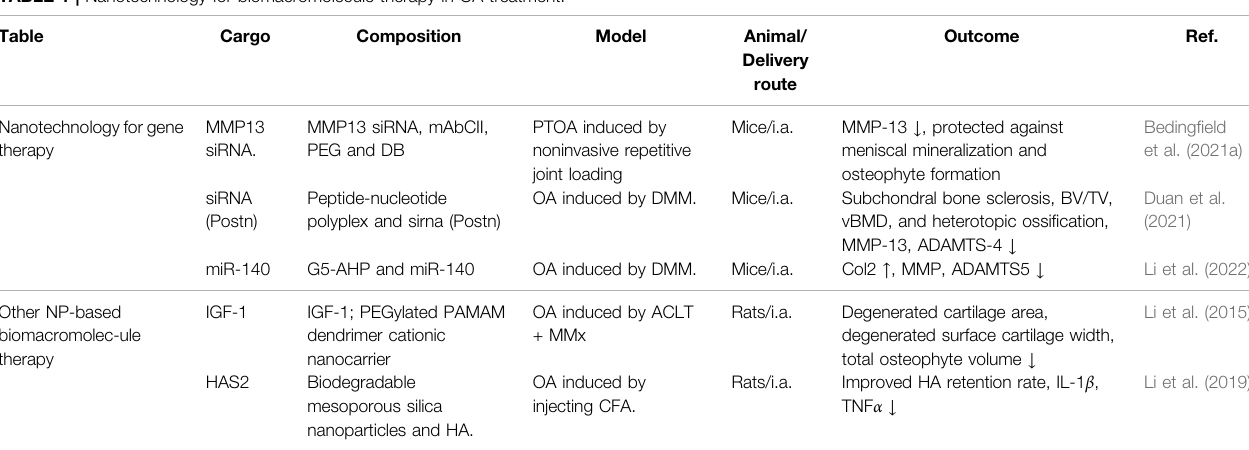
TABLE 1 | Nanotechnology for biomacromolecule therapy in OA treatment. Table Cargo Composition Model Animal/